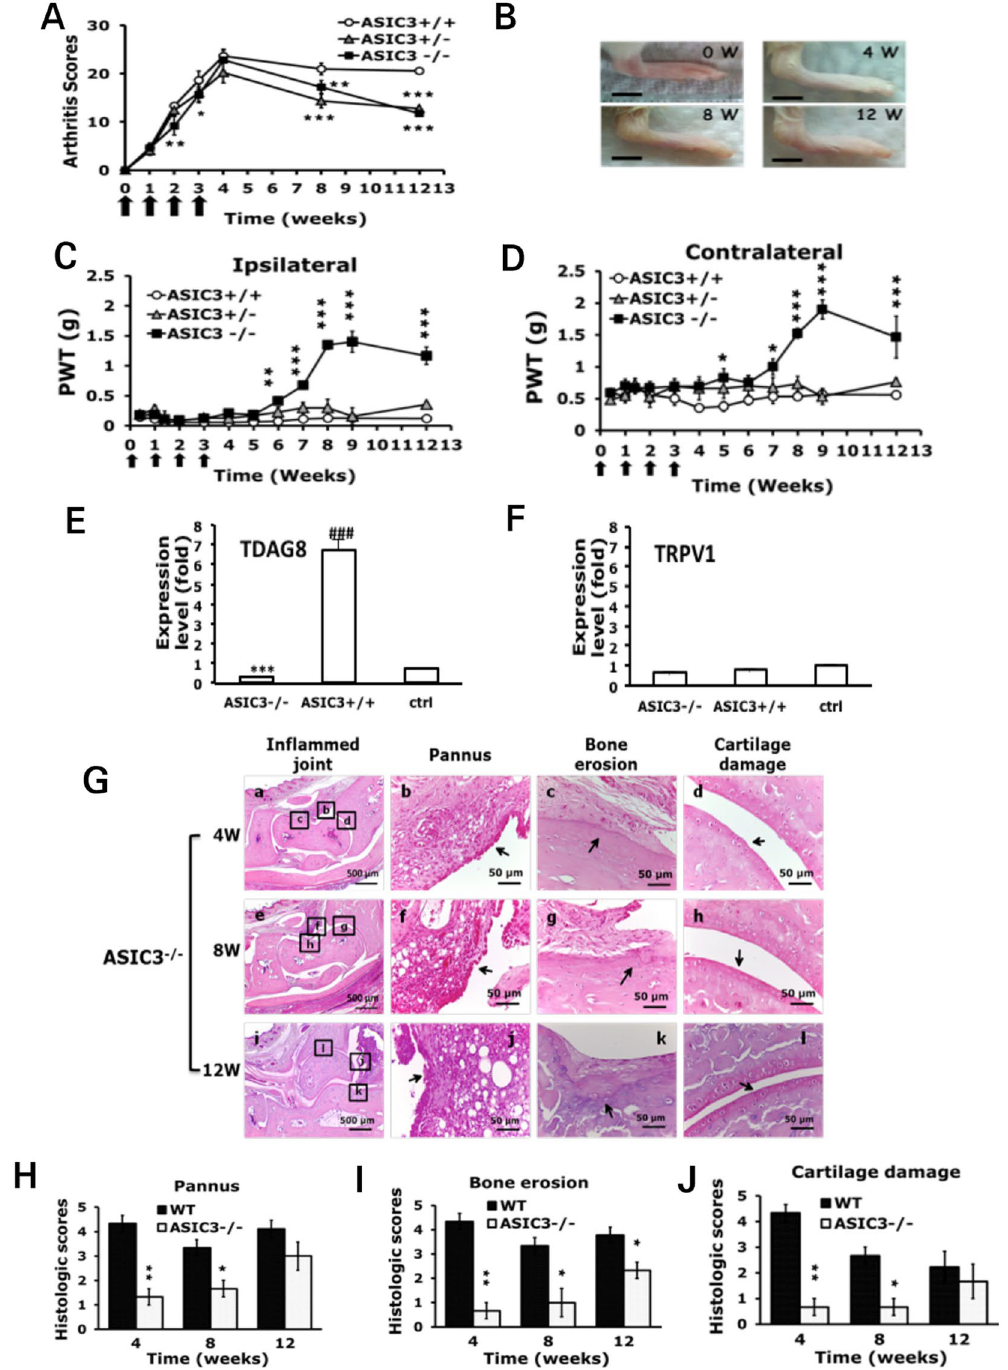
Figure 3. Arthritic ASIC3 − / − mice show reduced mechanical hyperalgesia in the late phase. ( A ) Arthritis scores in ASIC3 + / + , ASIC3 + / − and ASIC3 − / − mice. * P < 0.05, ** P < 0.01, *** p < 0.001, compared with ASIC3 + / + mice by two-way ANOVA. ( B ) Joint swelling in 0, 4, 8, 12 weeks in ASIC3 − / − mice. ( C , D ) PWT measured at weekly intervals after the first CFA injection. Data are mean ± SEM of total tested mice (n = 6 for ASIC3 + / + , n = 8 for ASIC3 + / − , n = 8 for ASIC3 − / − group). * p < 0.05, ** P < 0.01, *** p < 0.001, ASIC3 − / − vs ASIC3 + / + by two-way ANOVA. ( E , F ) qRT-PCR analysis of TDAG8 or TRPV1 gene expression in ipsilateral DRG at 12 weeks of ASIC3 + / + or ASIC3 − / − mice, or at 0 weeks of ASIC3 + / + mice (ctrl). *** p < 0.001, ASIC3 -/- vs ASIC3 + / + ; ### p < 0.001, ASIC3 + / + vs ctrl by one-way ANOVA. ( G ) Samples of joints at 4, 8, 12 weeks stained with hematoxylin and eosin are shown in (a-l). Data are mean ± SEM severity score for synovial inflammation ( H ), bone erosion ( I ), and cartilage damage ( J ). * p < 0.05, ** P < 0.01, comparing ASIC3 − / − vs wild type (WT) by nonparametric Mann-Whitney U